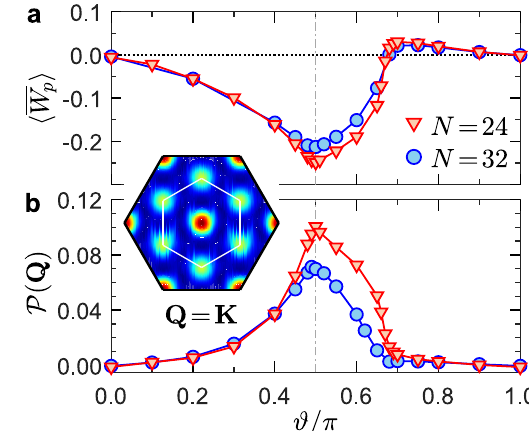
Fig. 8 Flux-like density and plaquette correlation. a Flux-like density h W p i and b plaquette order parameter Pð Q Þ for N = 24 (red triangular) and 32 (blue circle). The inset exhibits the plaquette structure factor of Γ model, which has a relatively weak peak at K point (corner of the Brillouin zone) in the reciprocal space.